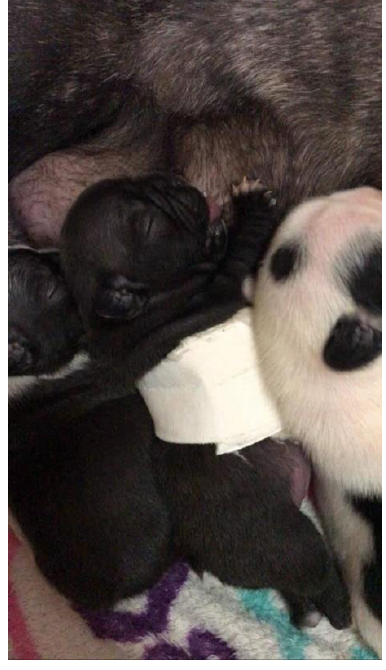
Figure 7. Patient nursing during splint use.